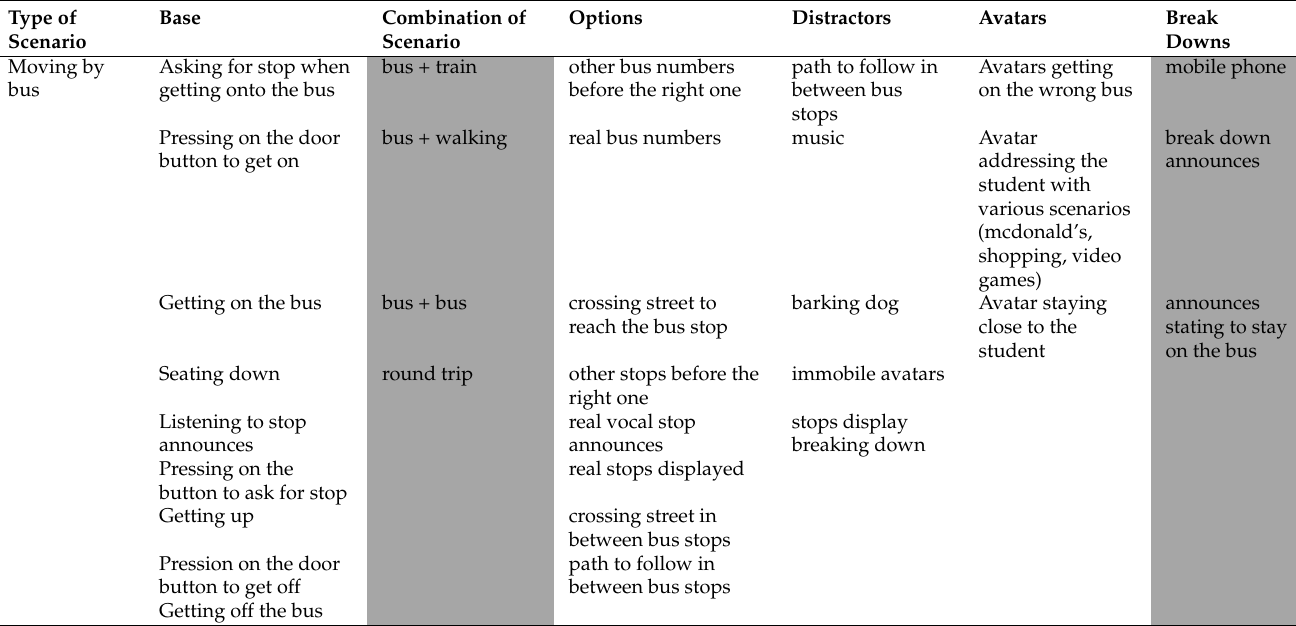
Table A2. Taking the bus scenario